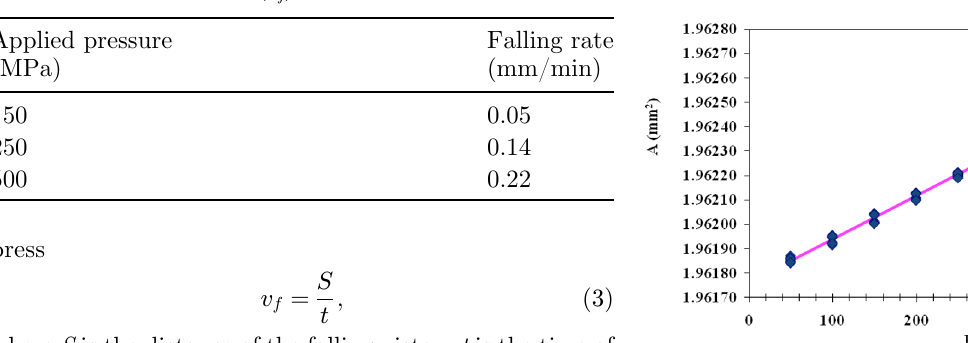
) at different applied pressure. f